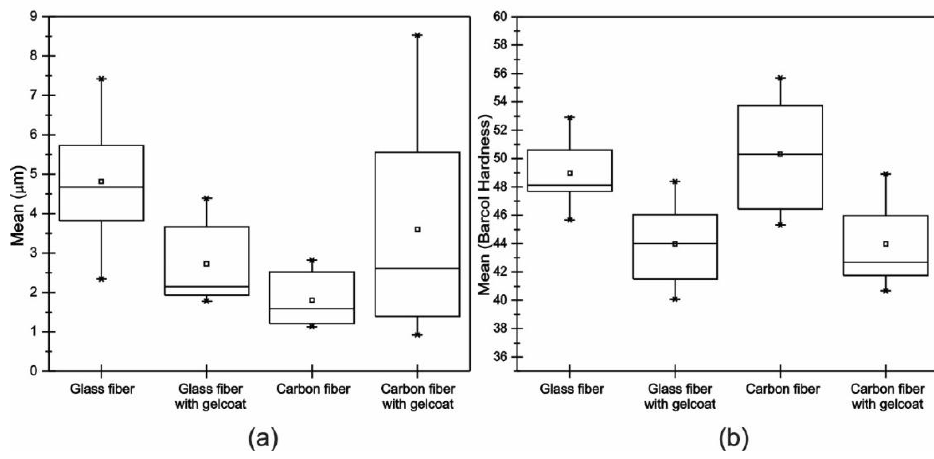
Figure 5. Box diagram of ( a ) roughness and ( b ) hardness. Table 1. Average values of roughness and hardness of the materials tested.